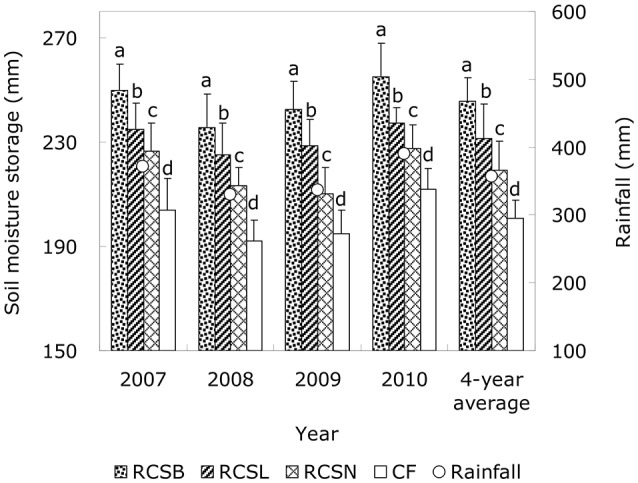
Average field water storage levels in the 0–100 cm soil layer during the growth period of corn from 2007 to 2010. RCSB means rain-harvesting ridges and furrows planting covered with 8% biodegradable films in furrows; RCSL means rain-harvesting ridges and furrows planting covered with liquid films in furrows; RCSN means rain-harvesting ridges and furrows planting with no films mulching in furrows; CF means the conventional flat planting without film mulching. Lowercase letters in the same year indicate significant differences among treatments (LSD test, P < 0.05). Bars represent standard deviations.